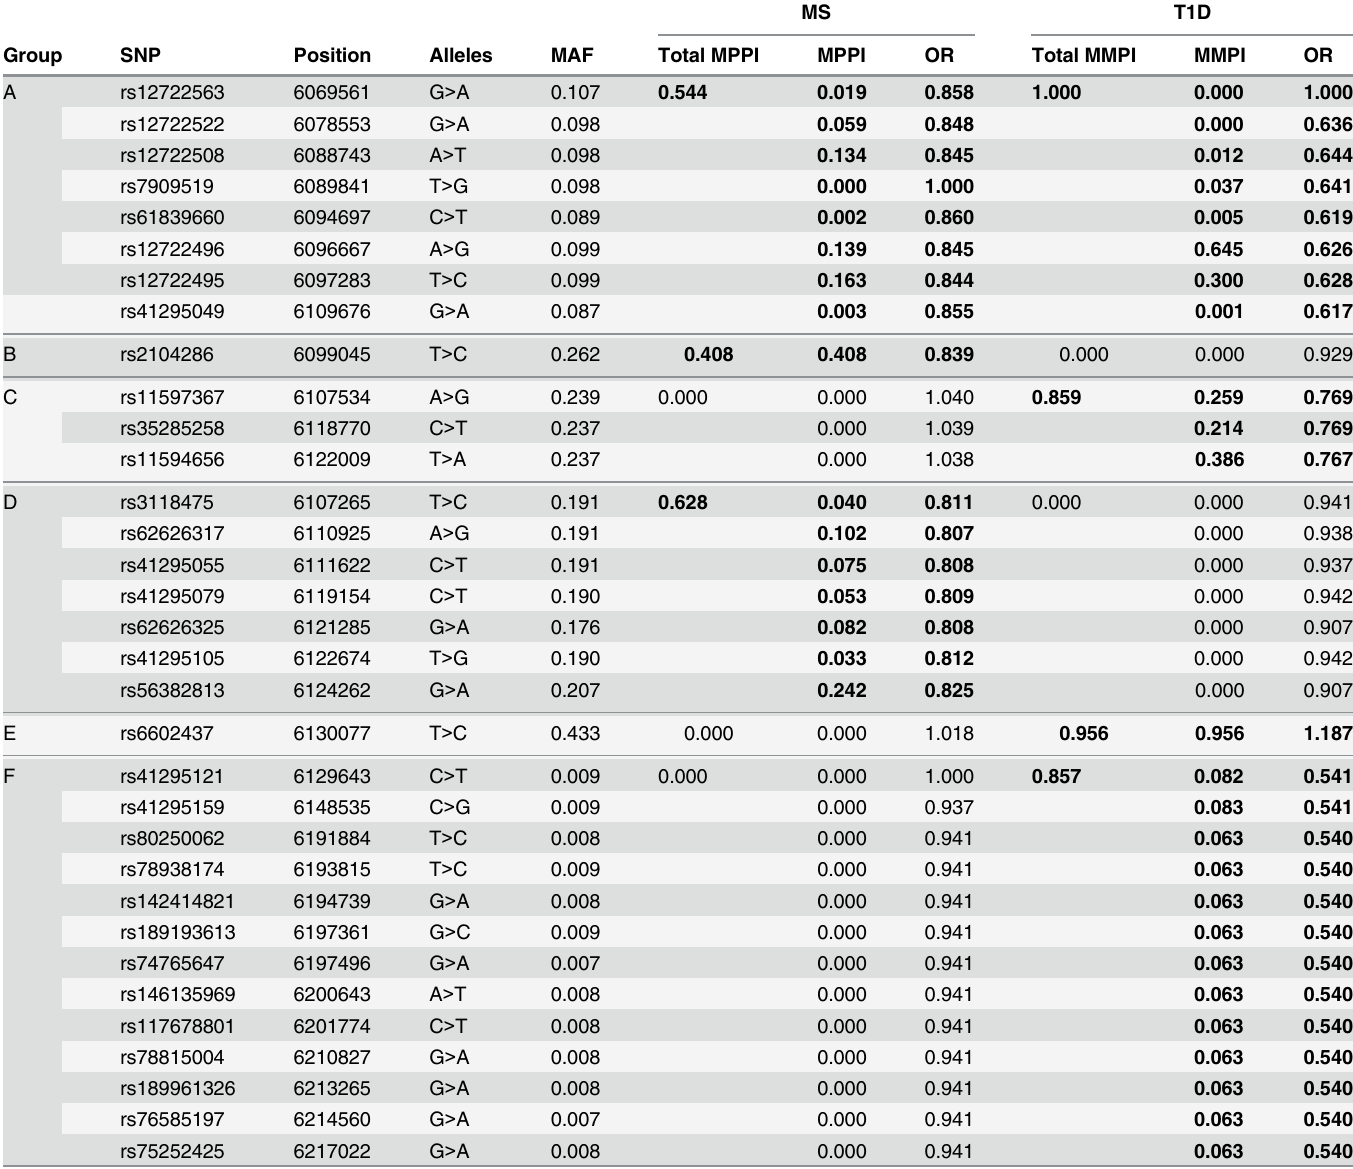
Table 5. SNPs selected by GUESSFM mapping of MS and T1D associations. SNP groups are labelled A-F for reference. Position is according to hg19; MAF = minor allele frequency in UK controls, OR = odds ratio for minor allele, MPPI = marginal posterior probability of inclusion. SNP groups are divided by horizontal lines, and the group MPPI (gMPPI) is the posterior probability of inclusion of any SNP in the group. We highlight in bold the SNP sets with some support for association with either MS or T1D. The MS model “ M1 ” consists of groups A and D, the model “ M2 ” consists of group